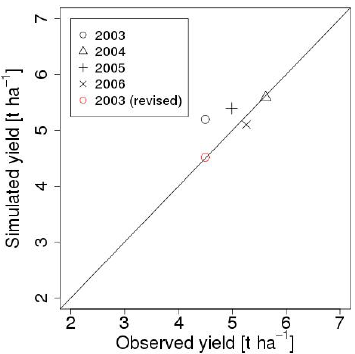
Figure 12. Comparison of yields between simulations and observa- tions.